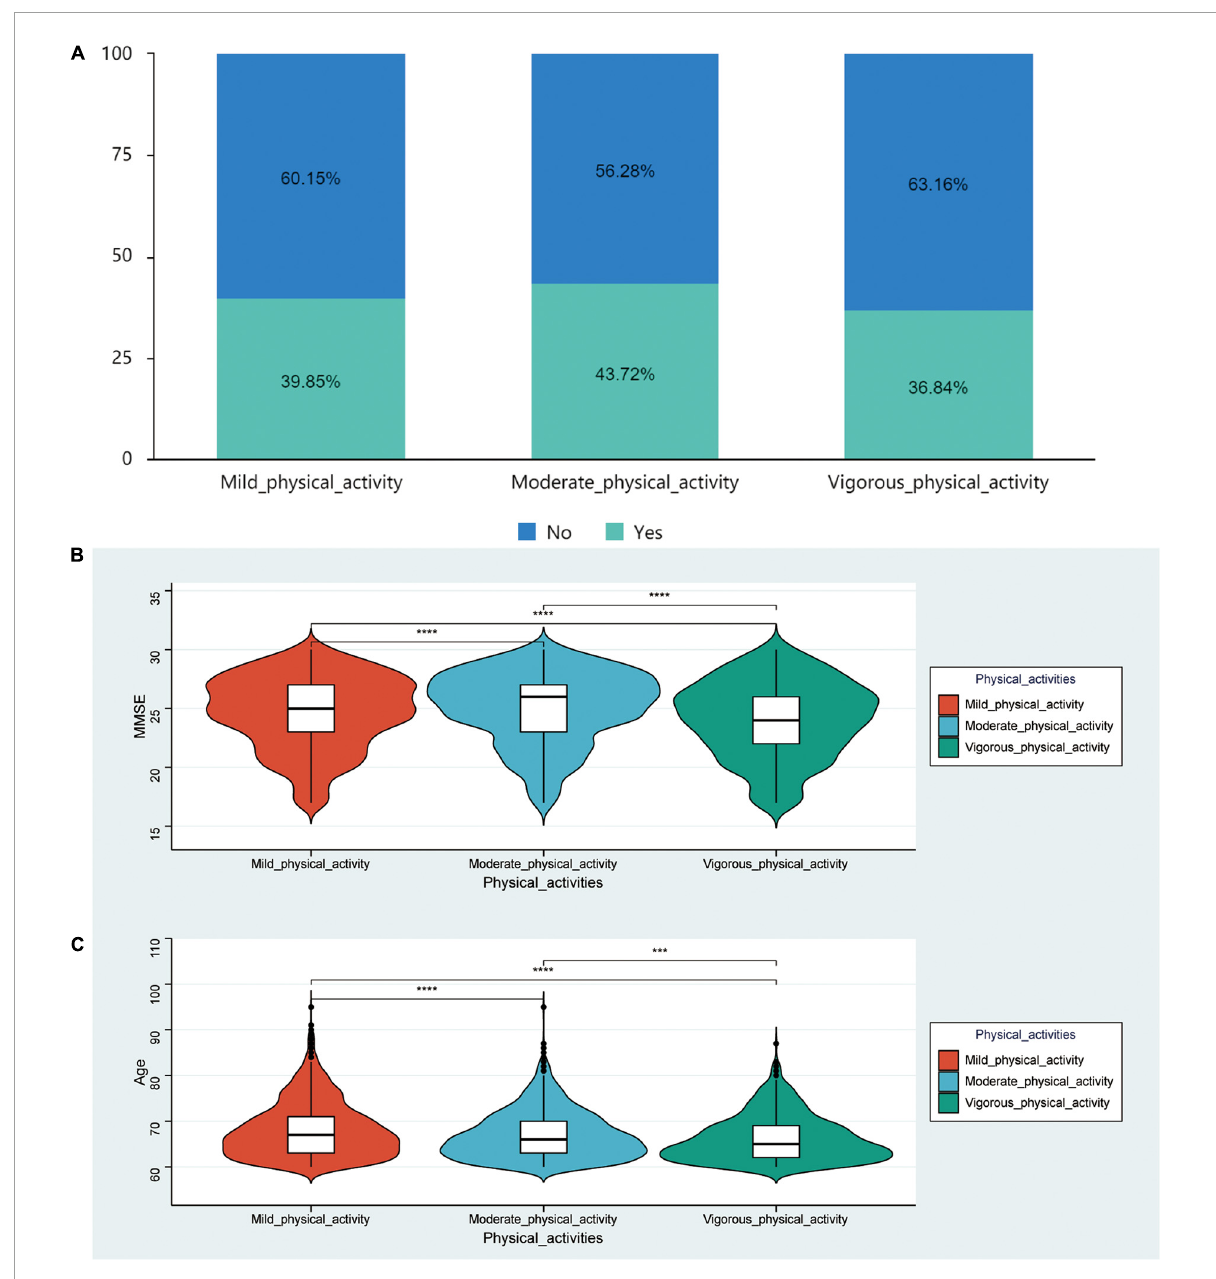
FIGURE3 Analysis of factors influencing physical activity. (A) Bar graph showing the difference in the proportion of denture wearing in different physical activities. (B,C) Bar graph showing the difference in MMSE (B) and Age (C) in different physical activities. *** p < 0.001, **** p <